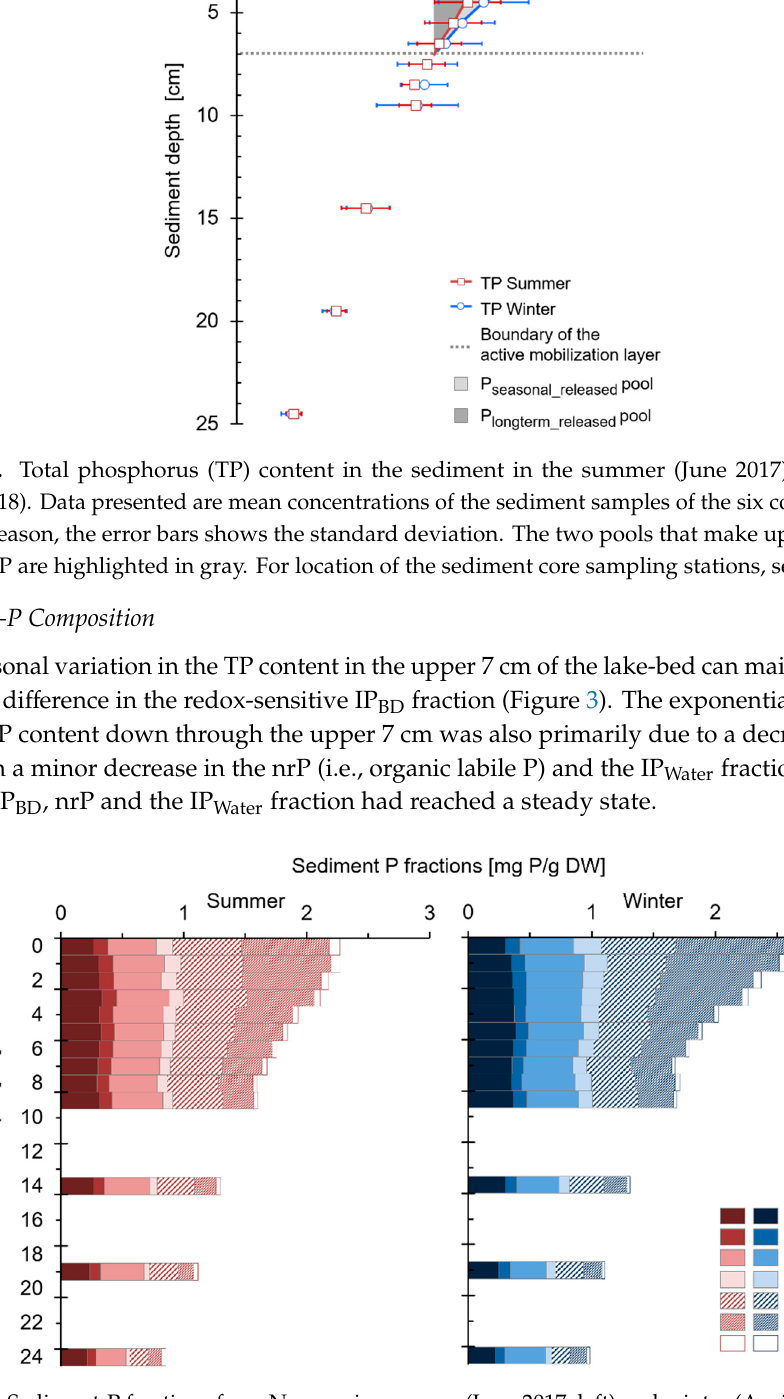
Figure 3. Sediment-P fractions from Nørresø in summer (June 2017; left) and winter (April 2018; right). Data presented are mean concentrations of the sediment samples of the six cores collected in each season. For location of the sediment core sampling stations, see Figure 1.